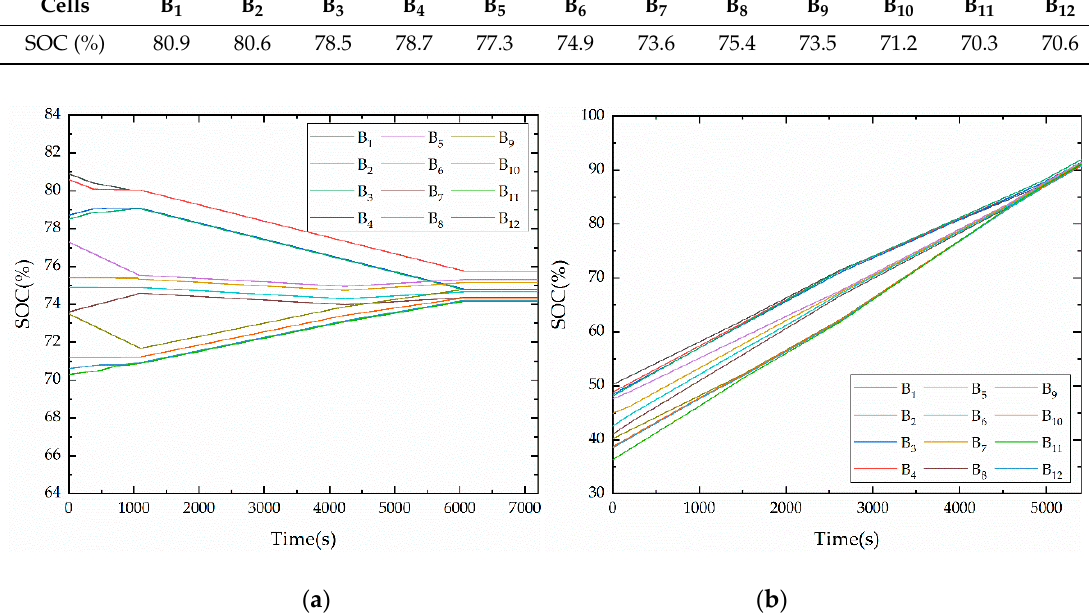
Figure 10. ( a ) SOC response with 12 retired cells of static equalization, ( b ) SOC response with 12 retired cells of charging equalization.